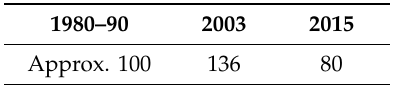
Table 6. YABs at Bulkwang Buddhist